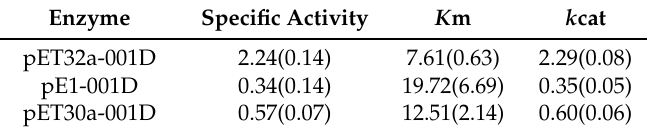
Table 1. Kinetic parameters for the purified carboxylesterases towards the 1-naphthyl acetate. Enzyme